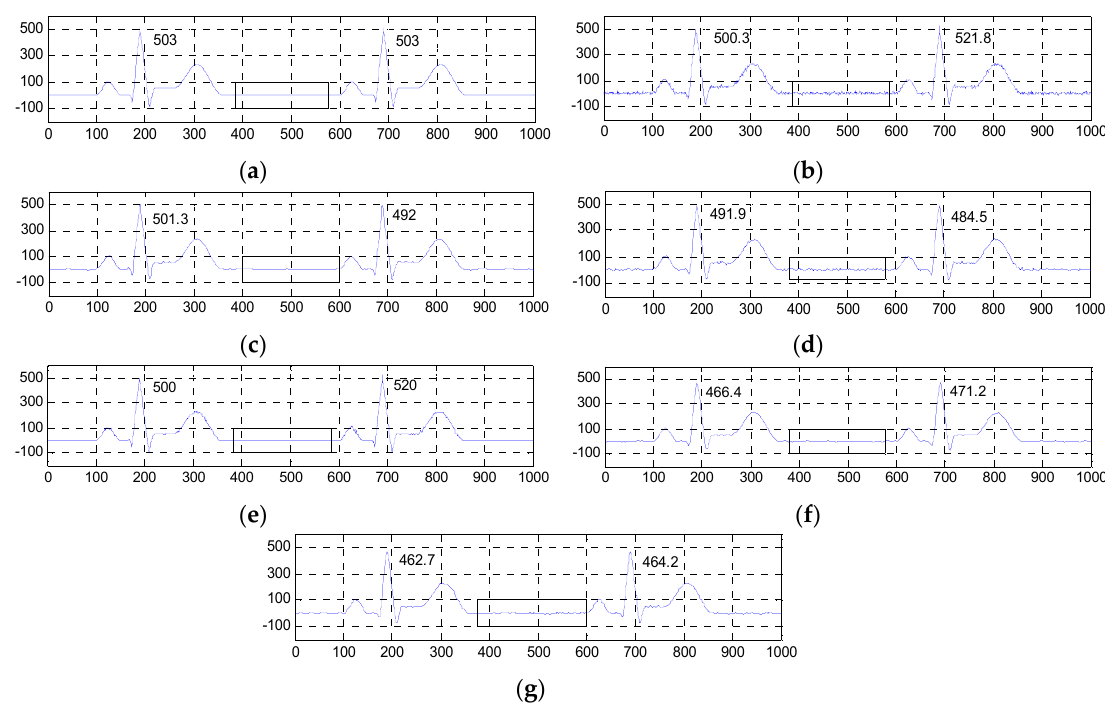
Figure 5. Comparison of denoised results of all evaluated methods operating on another simulated ECG signal. ( a )Tthe original ECG signal, ( b ) the noisy ECG signal (Gaussian white noise, σ 2 = 50), ( c ) the ESMD-NLM method, ( d ) the EEMD method, ( e ) the NLM method, ( f ) the VMD method, ( g ) the MED filter.